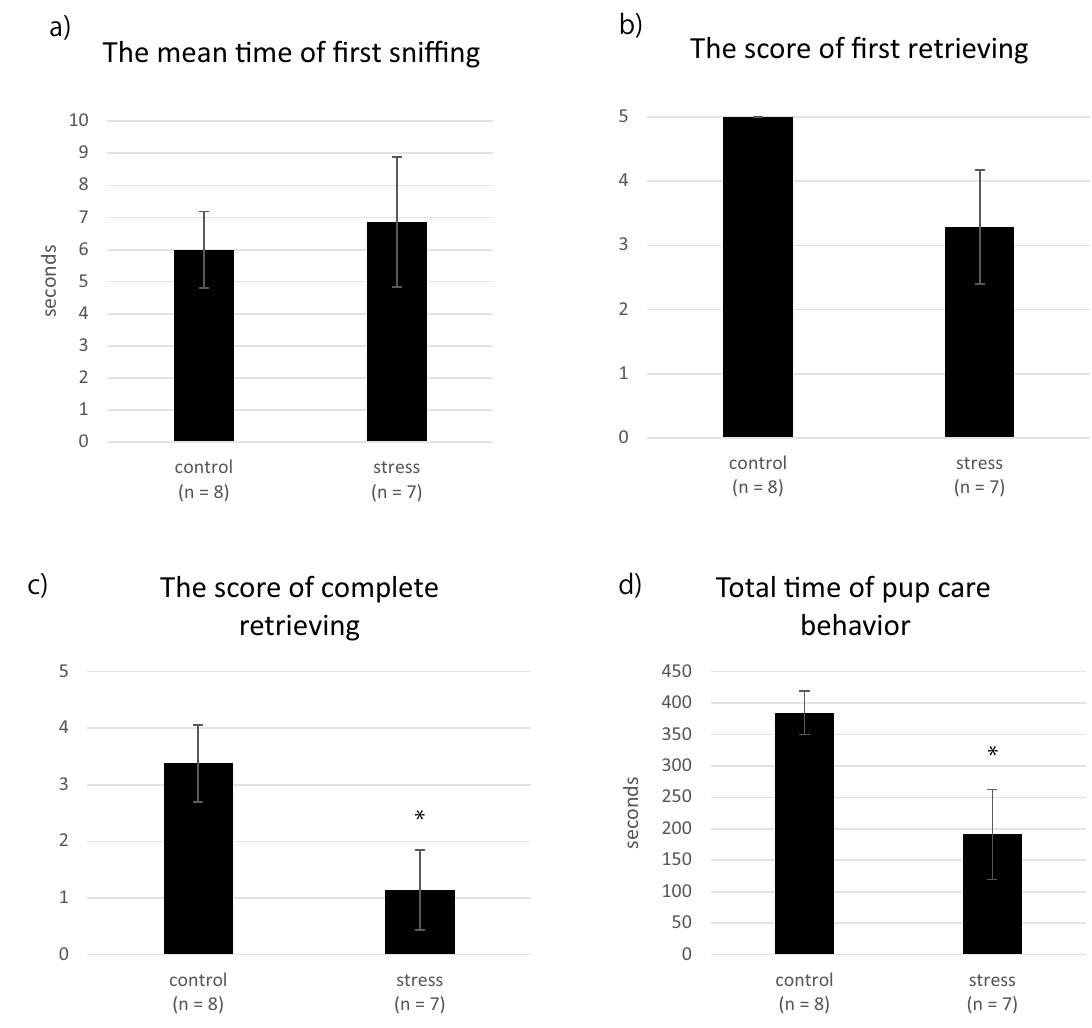
Figure 3. Comparison of nurturing behaviors. Data are shown as the mean ± standard error of the mean. The time of first sniffing ( a ), score of first retrieval ( b ), score of complete retrieval ( c ), and total time of nurturing behavior (d) in the control and stress groups of postpartum mice are shown. * p < 0.05 (t-test). n.s. Not